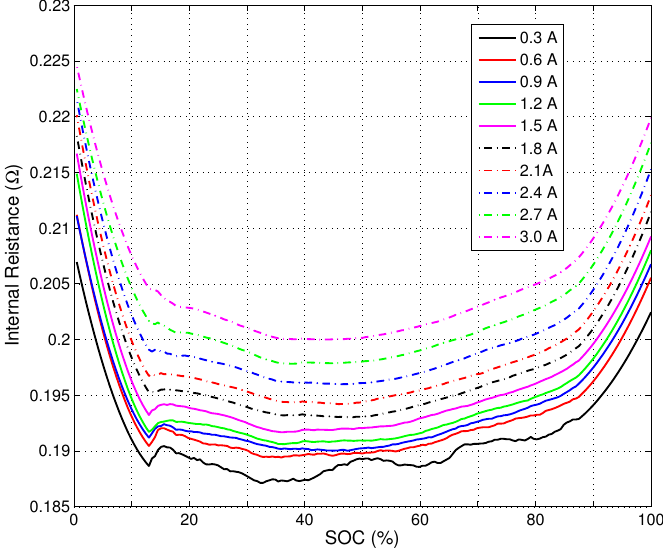
Figure 5. Internal resistance variation for different discharge currents and different SOC levels.